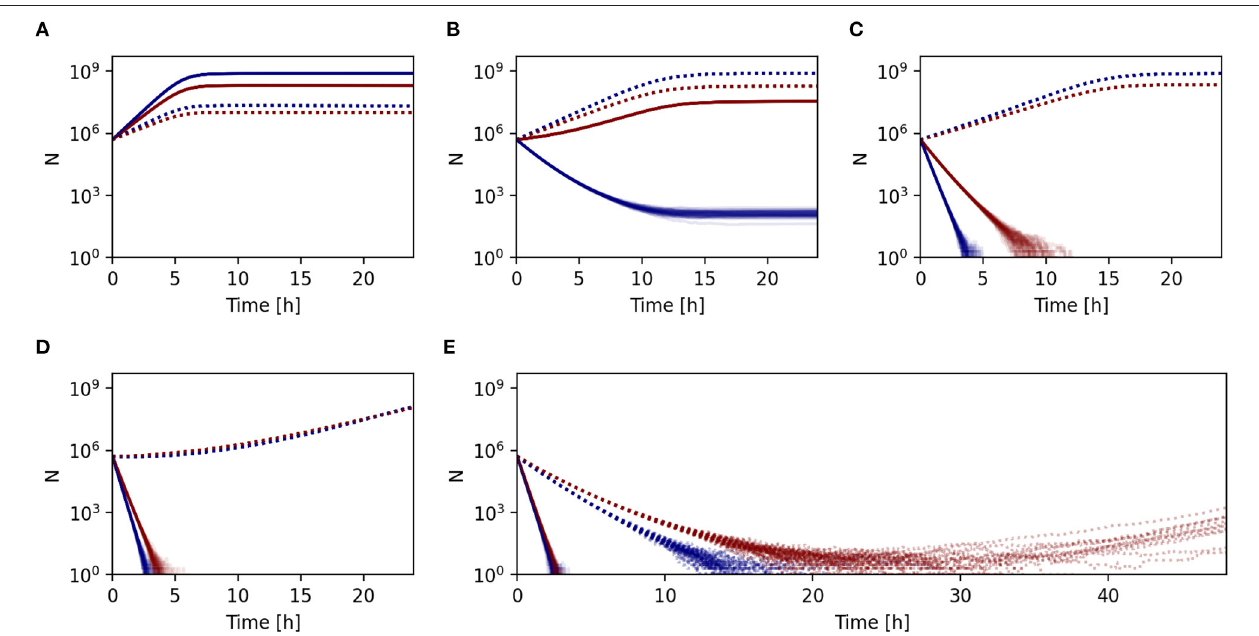
FIGURE 5 | Whether resistance evolved in either planktonic (solid lines) or biofilm (dashed lines) population depends on concentration of antibiotics the populations experience. Blue lines represent wild type, red lines represent mutant populations. Initial concentrations [MIC]: (A) : 0.1, (B) : 1.8, (C) : 5, (D) : 11.5, (E) : 32.